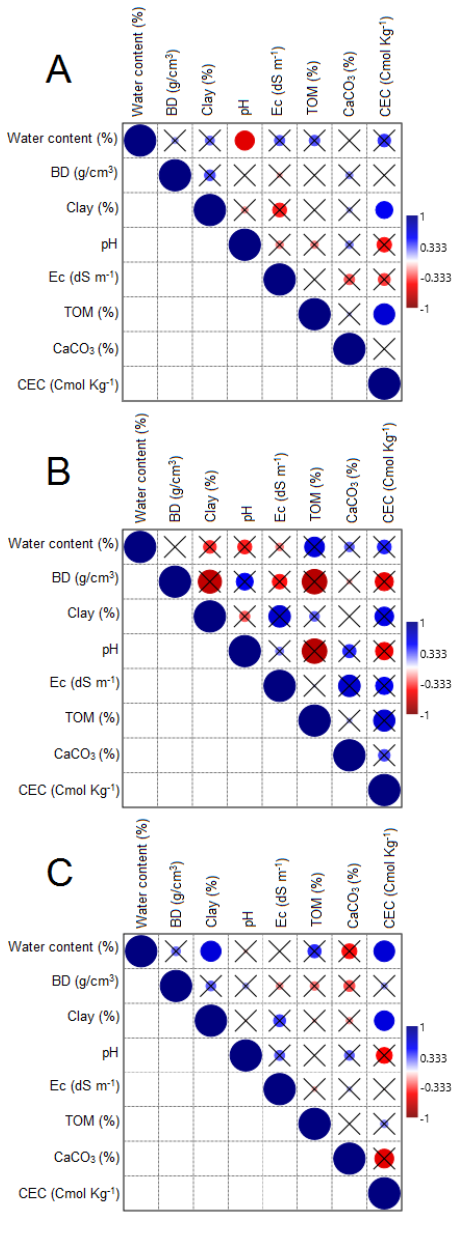
Figure 2. Correlations matrices between the studied soil characteristics in forest land (A), rangeland (B), and agricultural land (C). Circles sizes and colors represent Pearson’s correlation coefficient (r) value and p<0.05 the X over the circles stands for a non- significant correlation ( ).